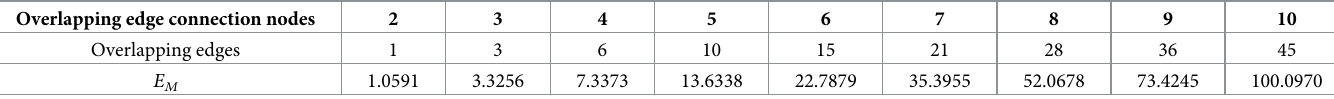
Table 1. Structure entropy of different overlapping edges and overlapping edge connected